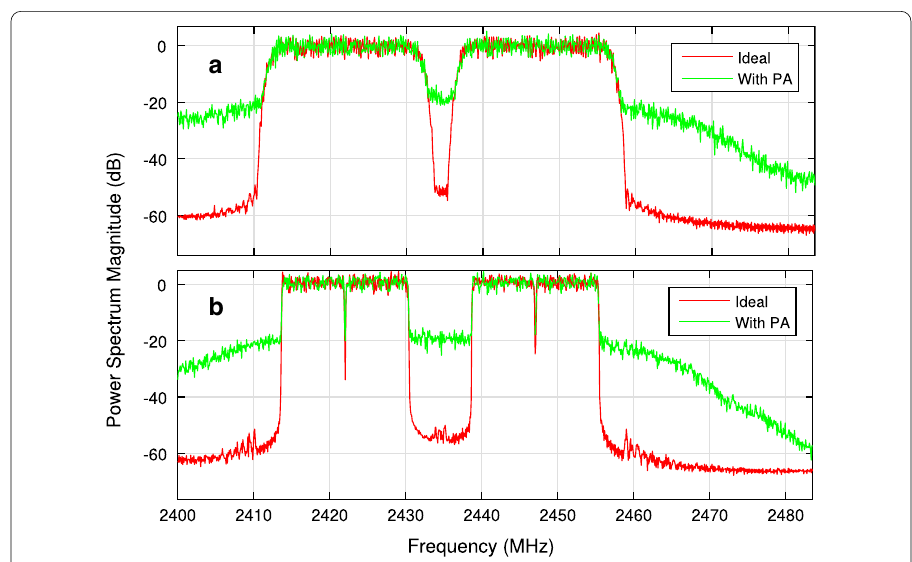
Fig. 3 Effects of the PA model on a OFDM and b FBMC-based PU spectra. A Wiener behavioral model with fifth order nonlinearity and 5 dB backoff is used for the